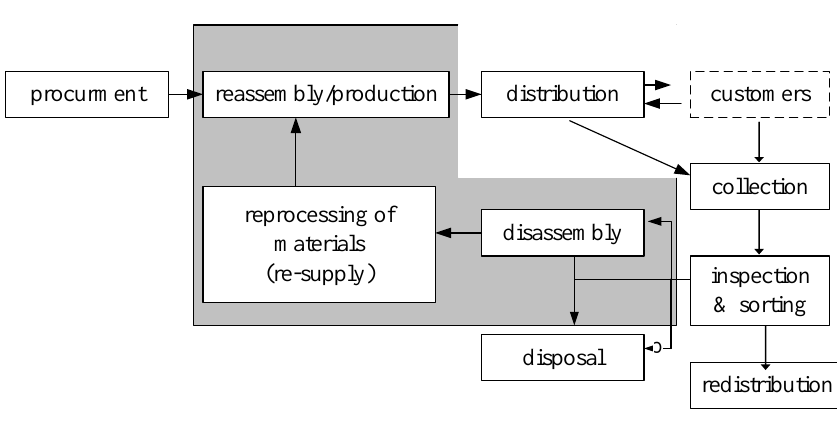
Figure 1. Closed loop supply chain model with